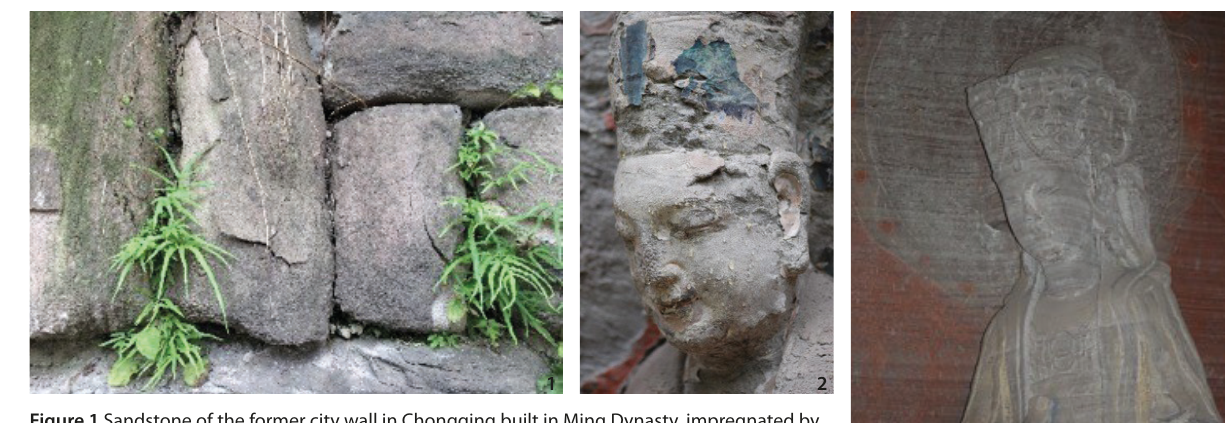
Figure 1 Sandstone of the former city wall in Chongqing built in Ming Dynasty, impregnated by methyl silicates and water repellents and peeled after 15 years later (Source: the author). Figure 2 Condensation on the surface of a Buddha figure which is well sheltered against precipi- tation (Source: the author). Figure 3 Fading of mural painting and accelerated stone deterioration of Buddha figure approxi- mately 20 years after a so called ‘environmental control measures’, according to oral report of Fangying Li 2018 (Source: the